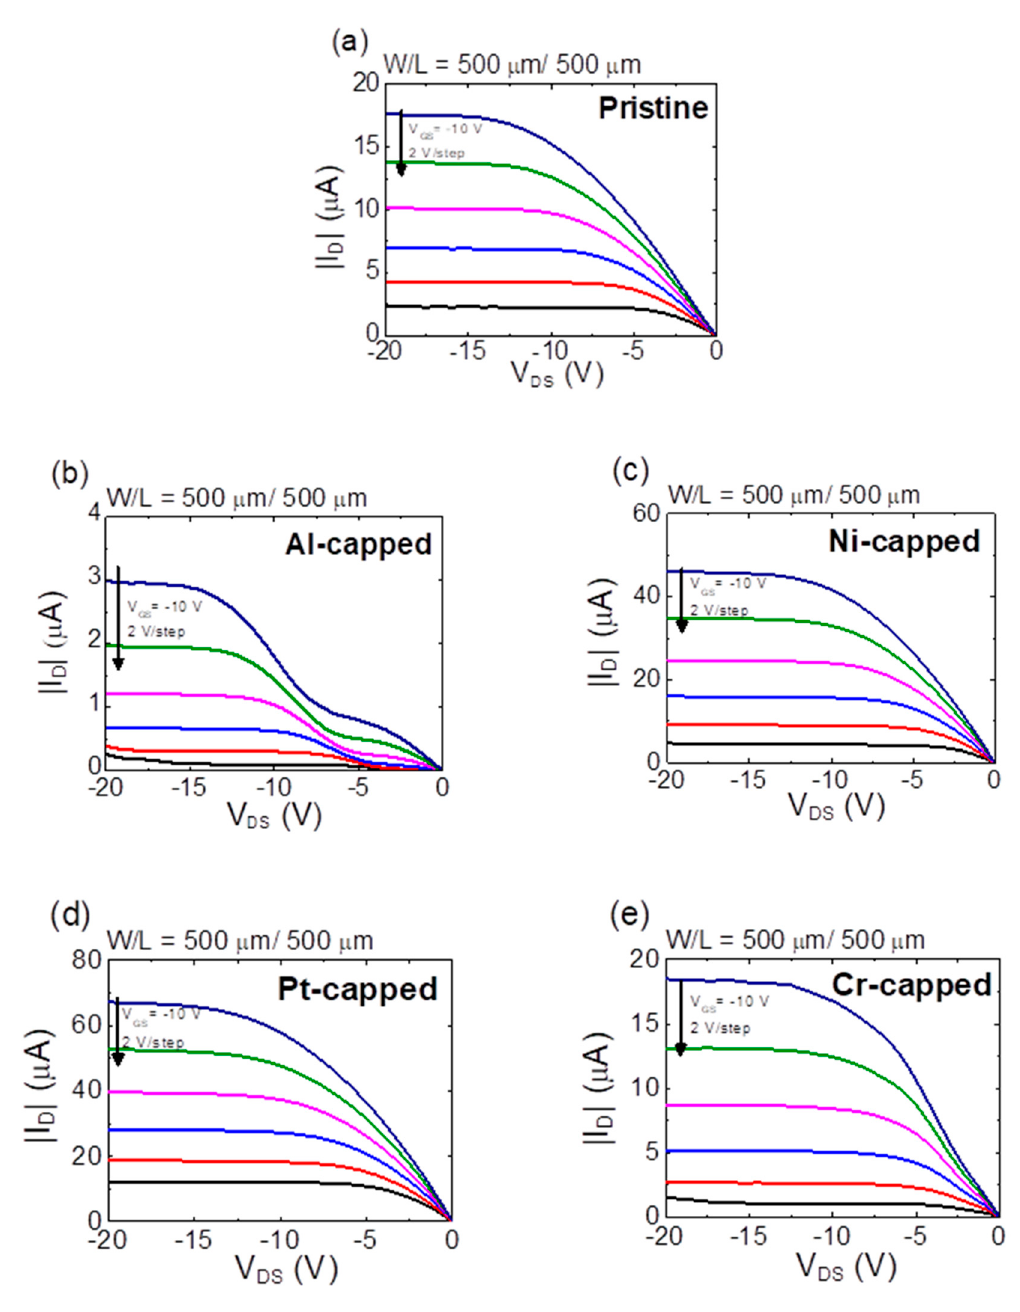
Figure 8. Output curves measured from the ( a ) pristine, ( b ) Al-capped, ( c ) Ni-capped, ( d ) Pt-capped, and ( e ) Cr-capped SnO TFTs.